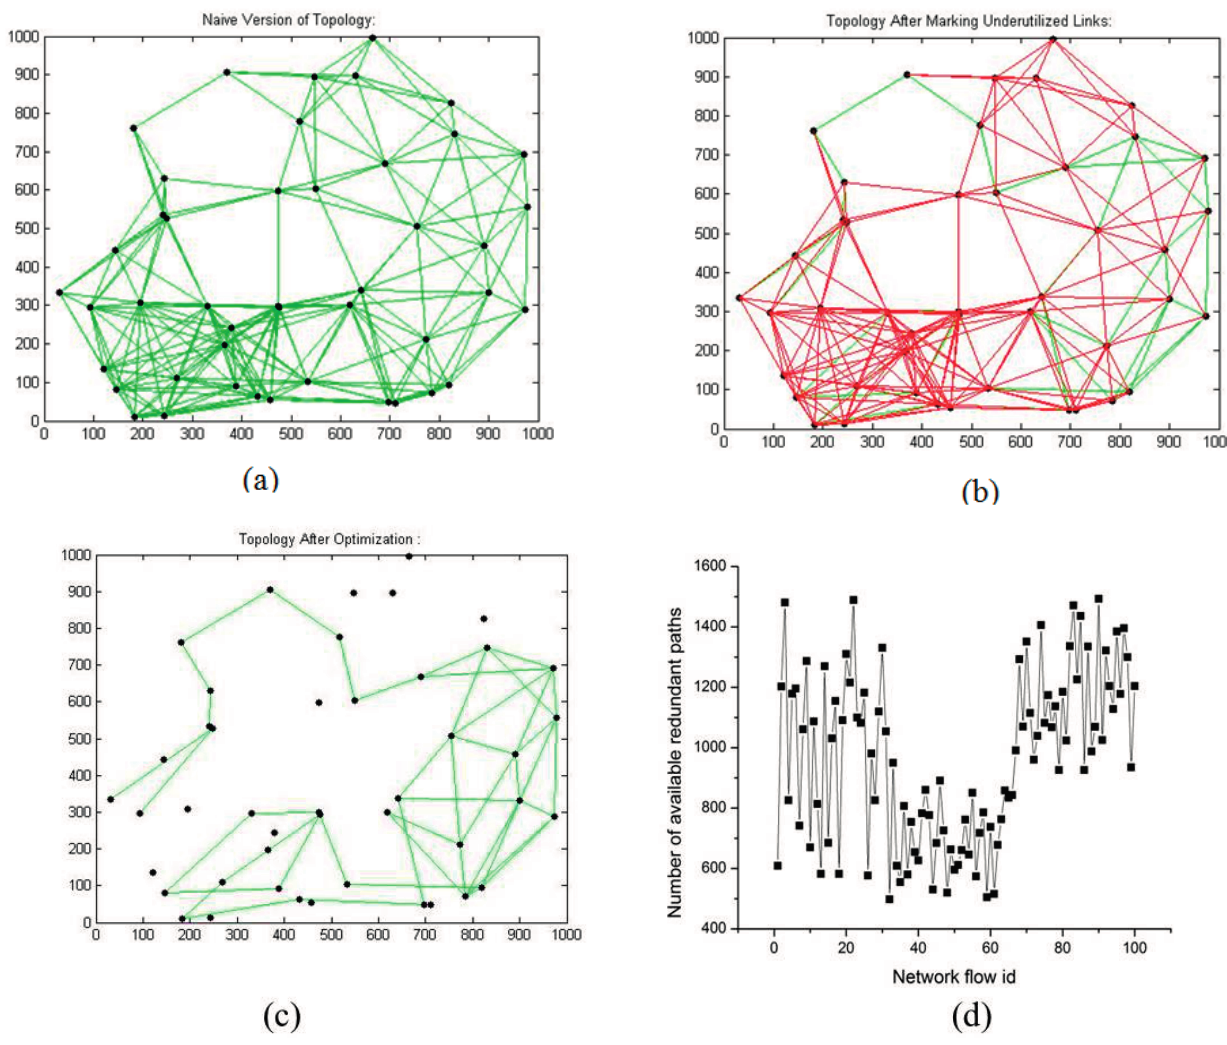
Figure 5. ( a ) 45 nodes’ naive topology; ( b ) 45 nodes’ marked topology; ( c ) 45 nodes’ optimized topology; ( d ) Path